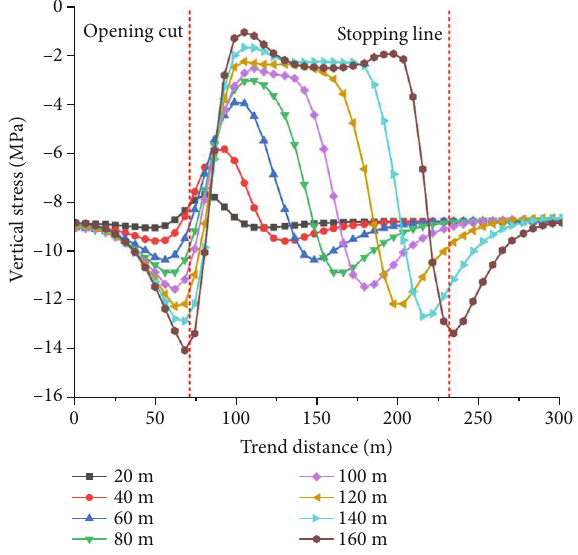
Figure 5: Vertical stress curves for upper C varying advancing